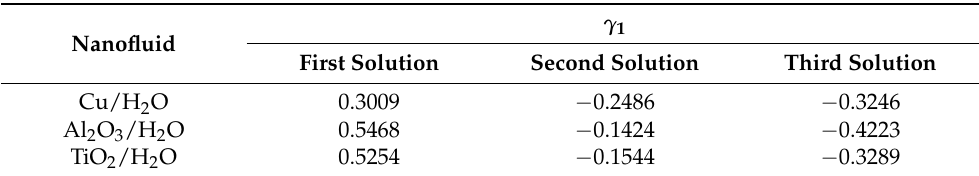
Table 3. Values of γ 1 for various nanofluid when φ = 0.2, λ = − 1, S = 3, K = 0.2, β 1 = 0.4, β 2 = 0.3 and β 3 =